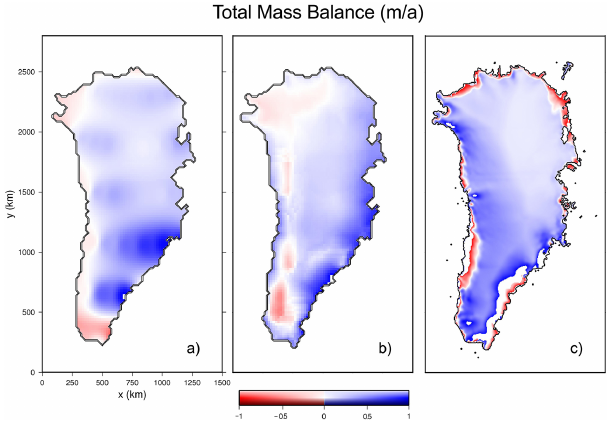
Figure 4. As Fig. 2, but for surface mass balance. Please note that the colour scale for this plot is linear. Data base for (c) : Bamber et al. (2001a).